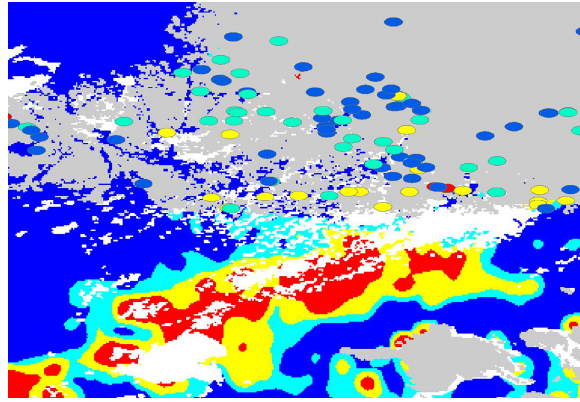
Figure 4: A detailed view of southern part of Finland to demonstrate how citizen observation can complement remote sensing based product (by the Finnish Environment Institute).